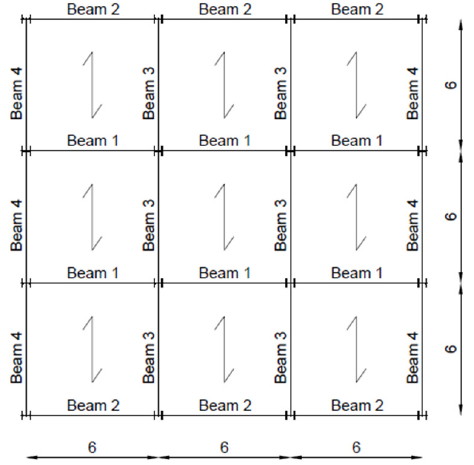
Figure 18. Mono-story building model with SAP2000.